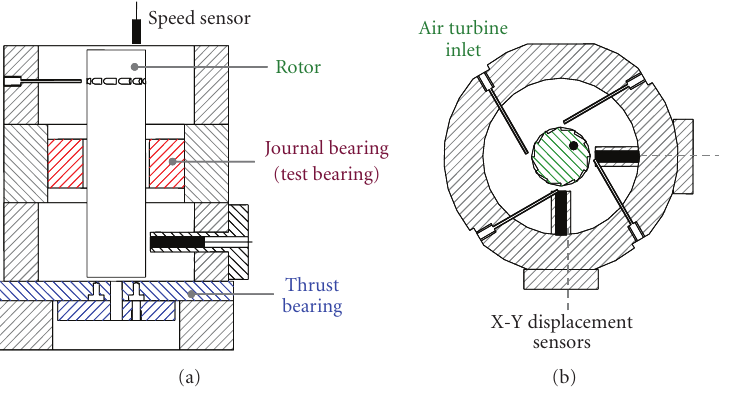
Figure 4: Schematic of the experimental test rig.